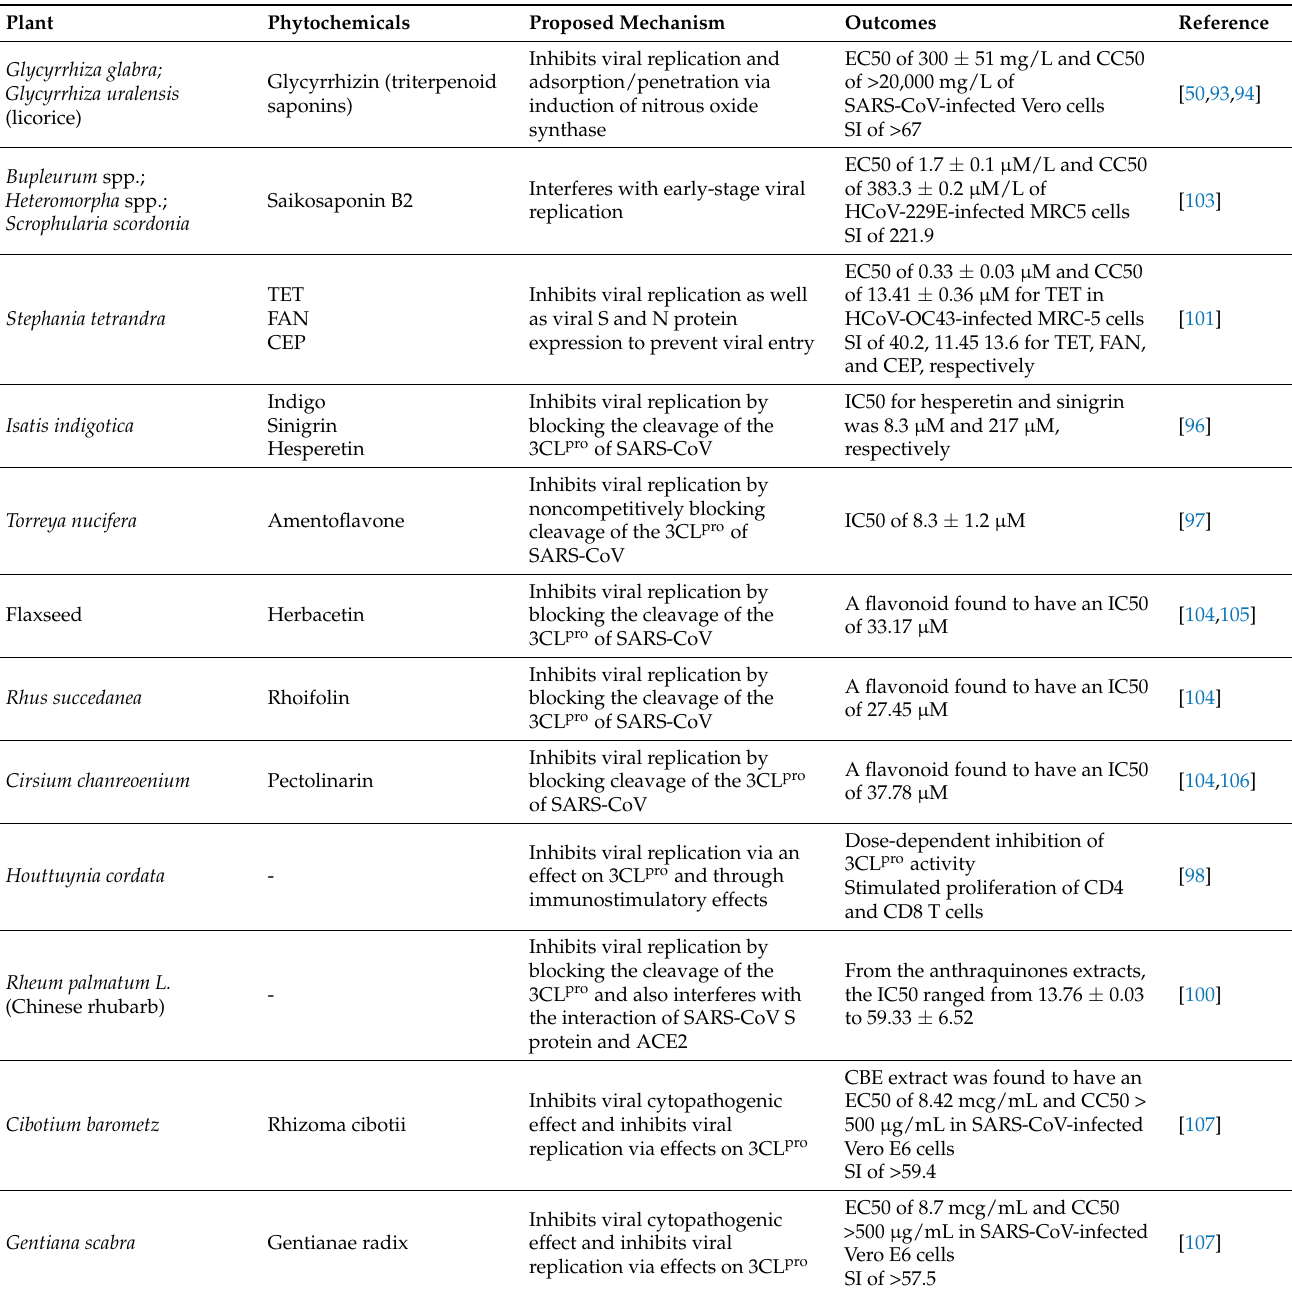
Table 2. Phytochemicals that may be beneficial as adjunct agents in